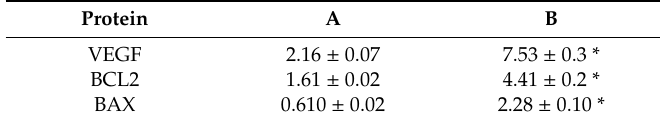
Figure 7. The effects of intraperitoneal (IP) injections of ENU on the expression of Beta actin, vascular endothelial growth factor (VEGF), B-cell lymphoma 2 (BCL2) and BCL2 associated X (BAX) in the spleens of male ICR-mice (representative samples). Key: ENU = n -ethyl- n -nitrosourea, A = control, B = treated with 80 mg/kg ENU twice with a 1-week interval. Table 5. Actin normalised values for relative expression of VEGF, BCL2 and BAX in ENU injected male ICR-mice.